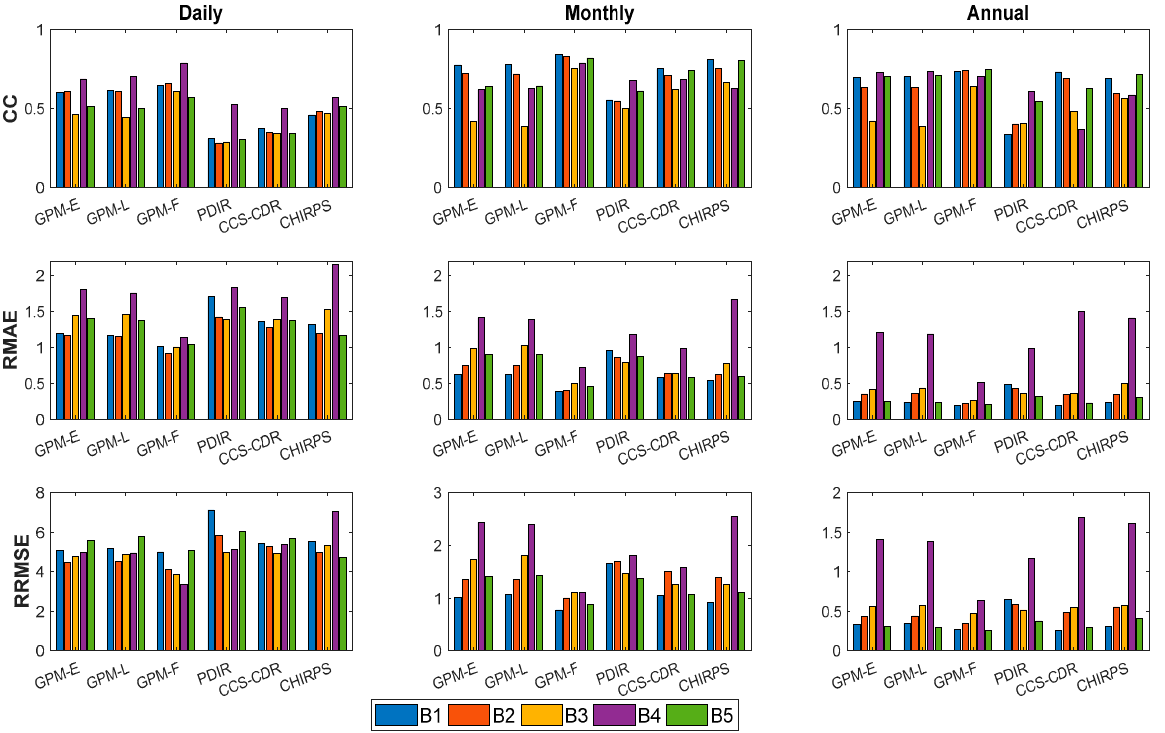
Figure 10. Continuous metrics for the five basins at the daily, monthly and annual scales.